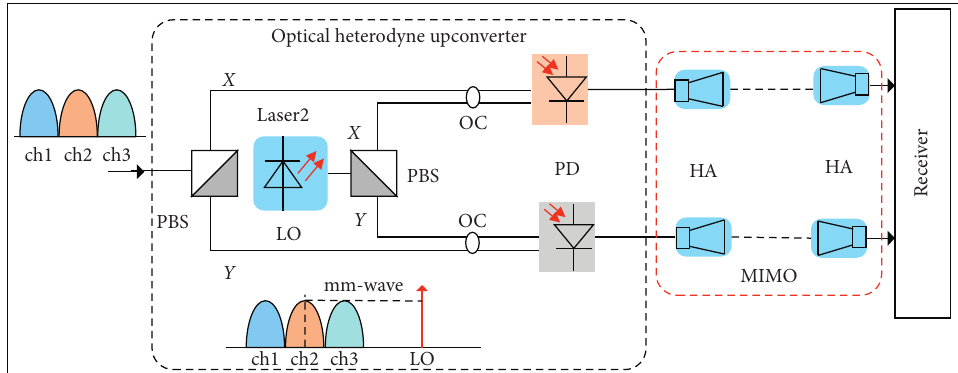
Figure 14: Schematic diagram of the combination of multicarrier modulation and the optical fiber wireless transmission network.